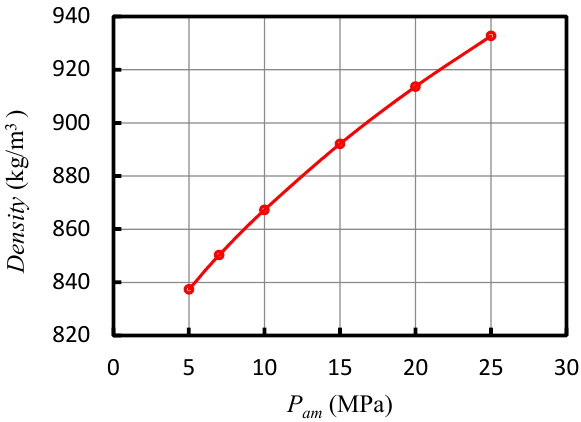
Figure 12. The density of SC-CO 2 fluid versus ambient pressure under constant ∆ P (Data from REFPROP).